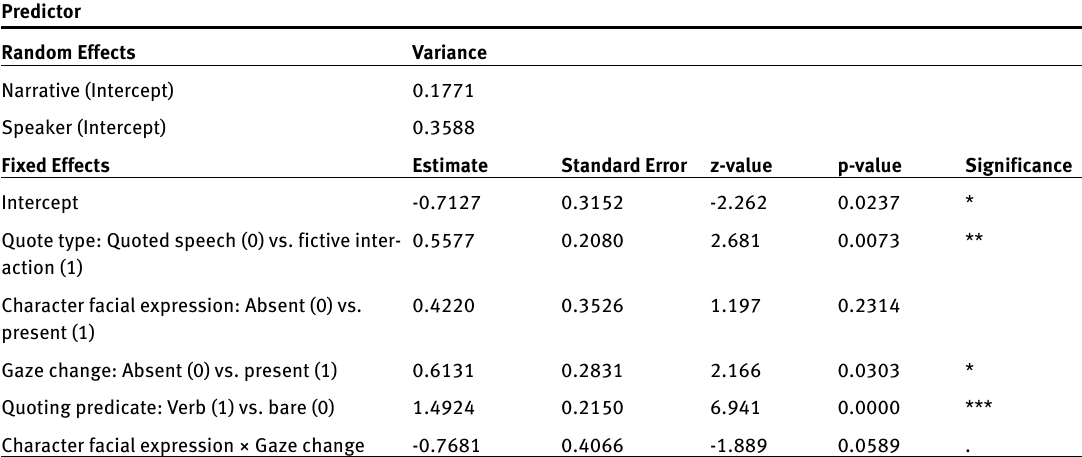
Table 10: The best generalized mixed-effects regression model for initial utterances in any quote sequence. Only predictors for the best-fit model are shown. Negative estimates indicate lower probability. Significance is indicated as follows: *** indicates p < 0.001, ** p < 0.01, * p < 0.05 and . p <